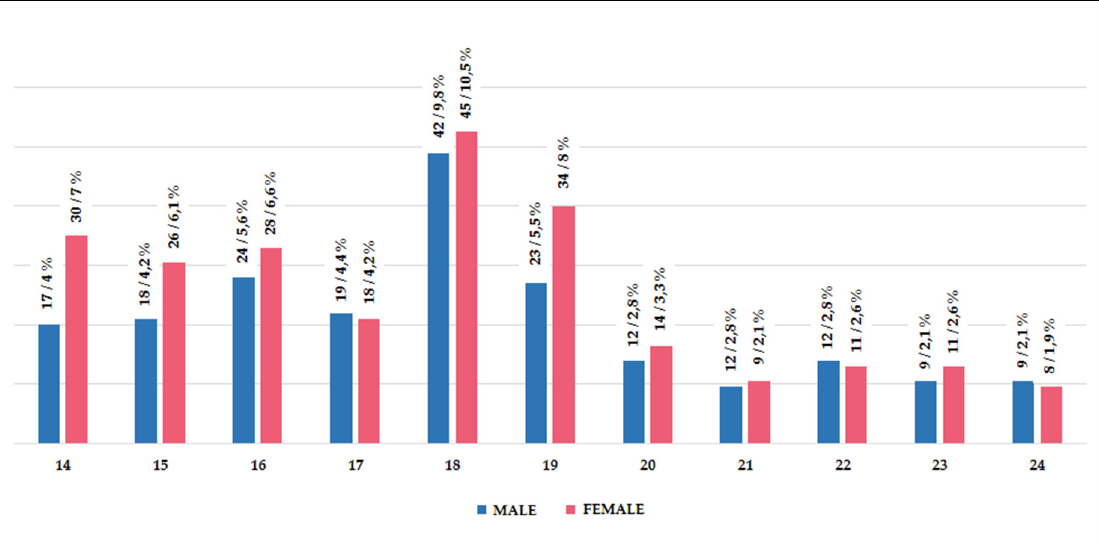
Figure 1. Frequency and percentage of young people according to their sex and age.